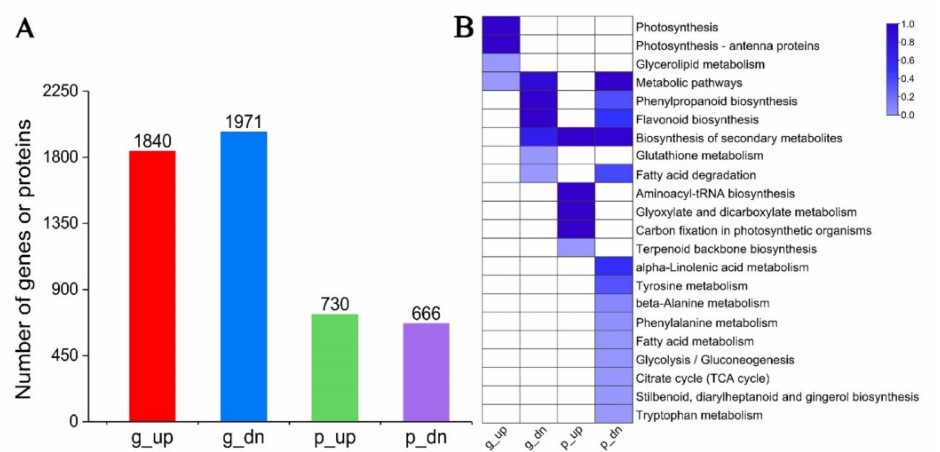
Figure 4. Identification of DEGs/DEPs. ( A ) Number of DEGs/DEPs. ( B ) Functional category enrichment of DEGs/DEPs. DEGs/DEPs were classified into two groups of up-regulated or down- regulated, without DEGs and DEPs comparison. The degree of the pathway enrichment was indicated according to the value of − log( q -value), as shown in the color bar. Each group was indicated by expression level (“g” for gene and “p” for protein, respectively) and regulatory direction (“up” for up-regulated and “dn” for down-regulated, respectively). The color brightness represents the degree of significant enrichment of pathways, as shown in the color